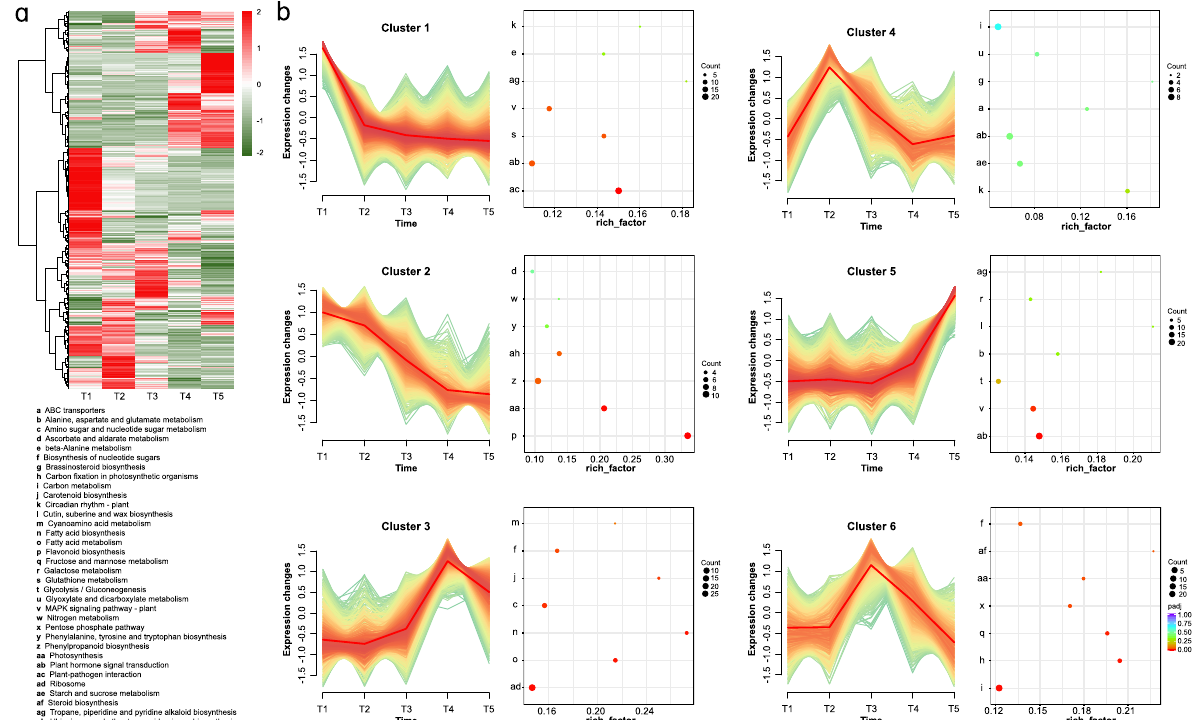
Figure 3. Gene expression profiles and KEGG enrichment analysis of the DEGs in the six common expression clusters composing the fruit transcriptome. ( a ) Heatmap of the overall common expression pattern. Heat maps depict the normalized gene expression values, which represent the mean value of three biological replicates. ( b ) Expression patterns and KEGG pathway annotations of 6 clusters. Each line represents the normalized gene expression values for an individual transcript. The y-axis of each cluster is the pathway name, while the x-axis represents the rich factor. Significantly overrepresented KEGG categories are represented by red